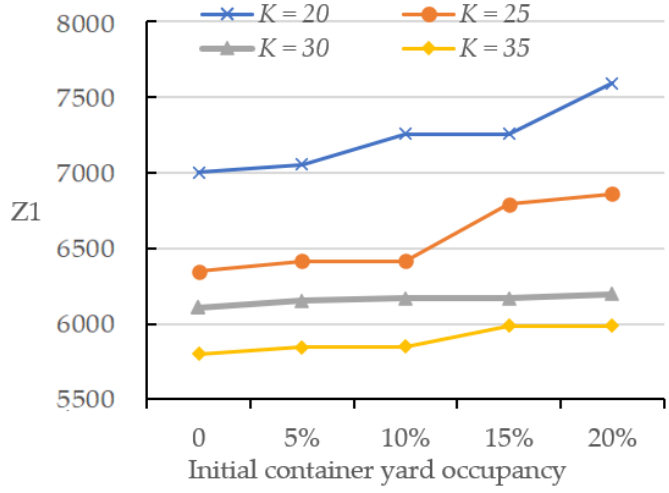
Figure 16. The effect of initial container yard occupancy on the queuing system.